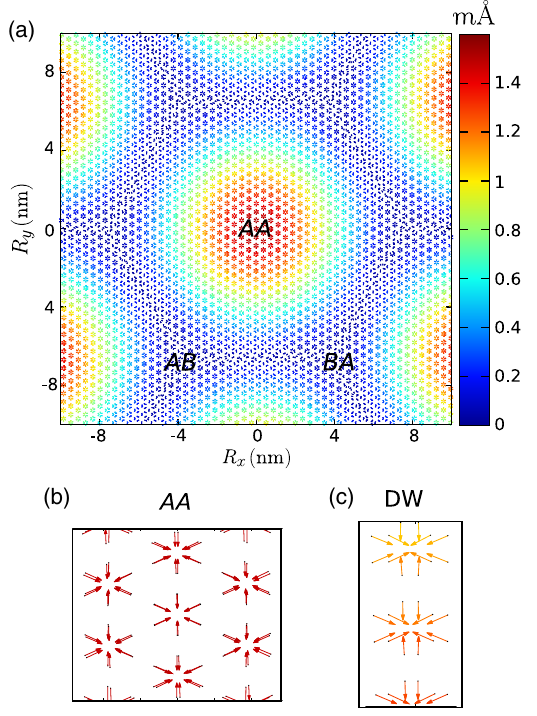
FIG. 6. (a) Atomic displacements on one of the two layers corresponding to the A 1 symmetry moir´e mode of the phonon doublet marked by a red arrow in Fig. 5. The direction of displacement is represented by a small arrow centered at each atomic position, while its modulus is encoded in colors. The mean displacement per atom is 0.57 mÅ. (b) Enlargement of the center of an AA region, shown for both layers. (c) Enlargement along one of the domain walls. Note the similarity with the ad hoc displacement in Fig. 3.